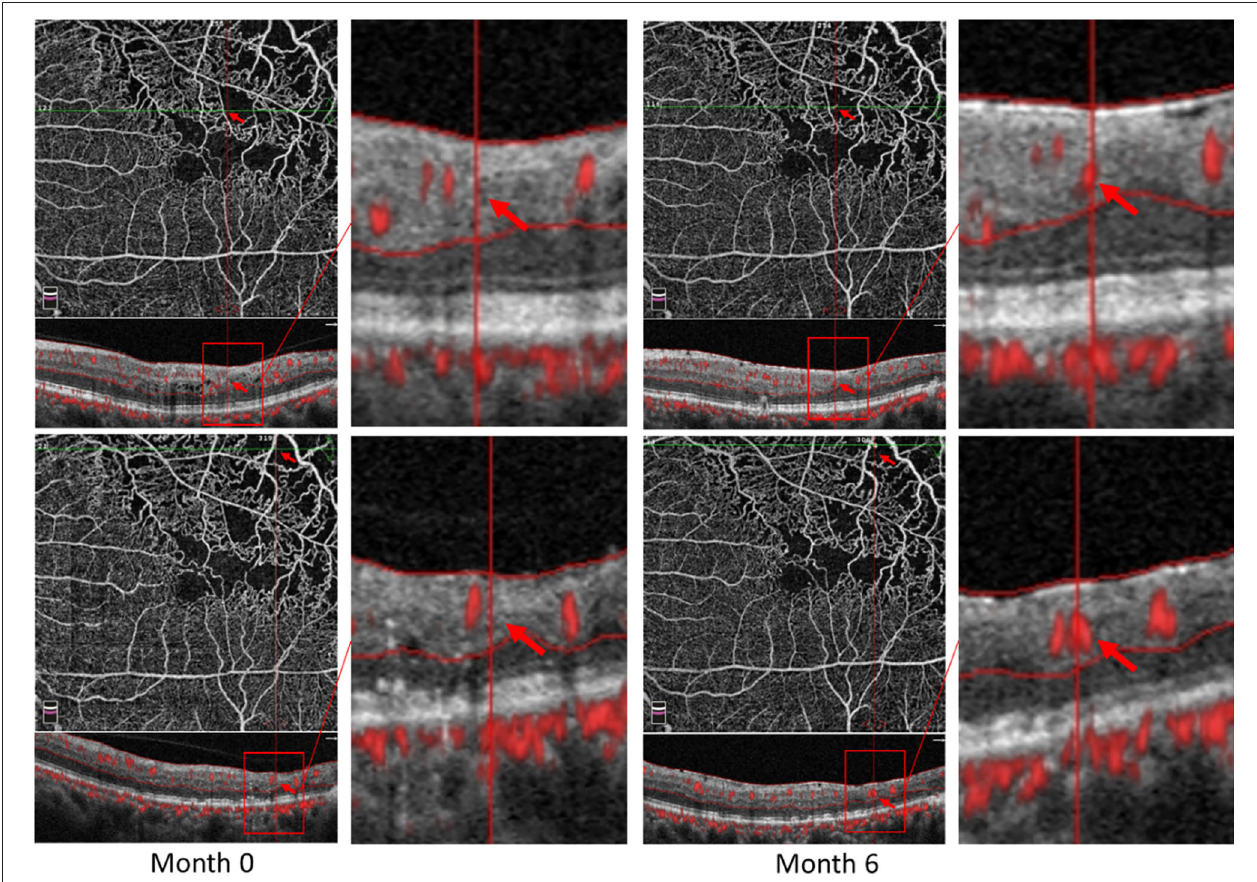
FIGURE 4 | Reperfusion occurred in the left eye of a 56-year-old male with macular ischemia after receiving anti-VEGF treatment. Red arrows indicate the growth of new capillaries and reperfusion in the macular nonperfusion